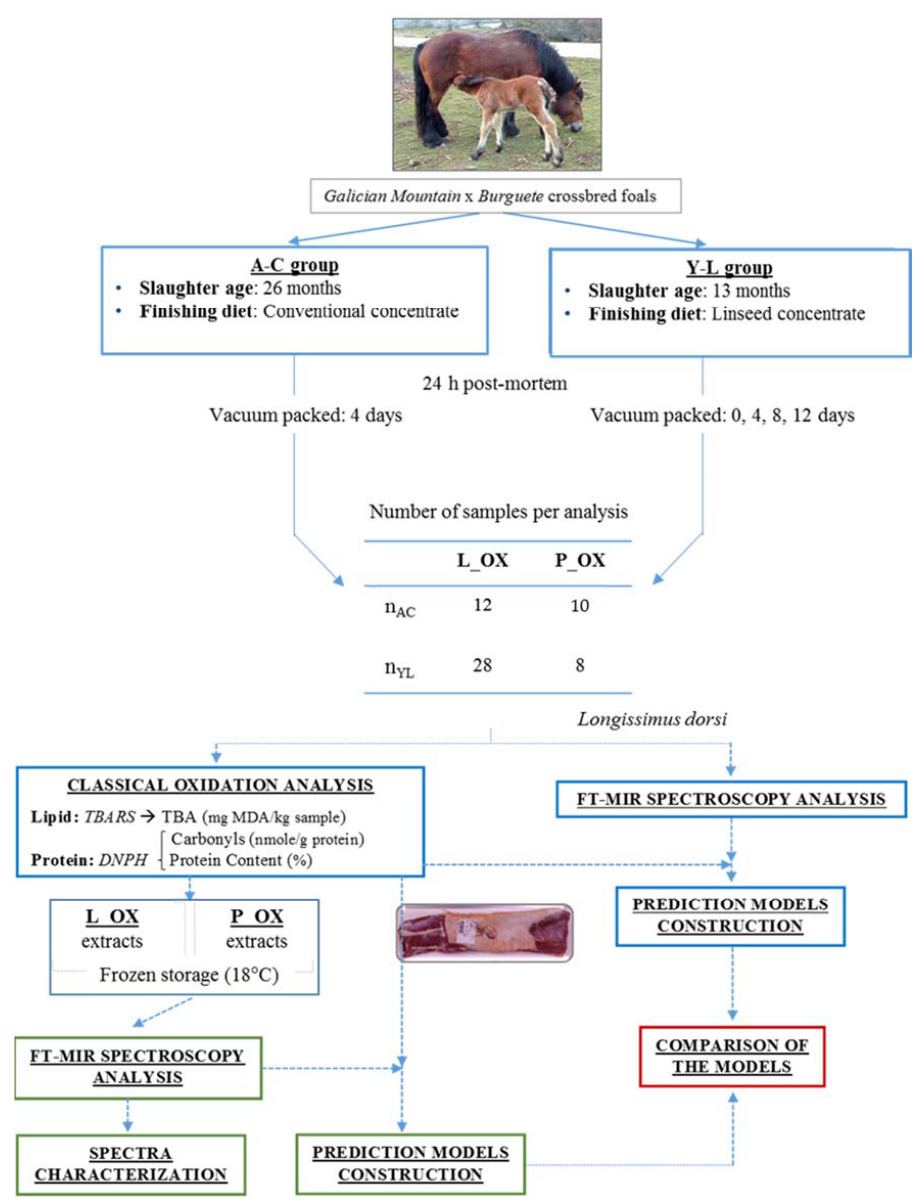
Figure 1. Scheme of the experimental design for both models performed in this work (n AC : number adults on concentrate; n YL : number youngs on linseed; TBARS: Thiobarbituric Acid Reactive Substances; DNPH: Dinitrophenylhydrazine; L_OX: lipid oxidation; P_OX: protein oxidation).